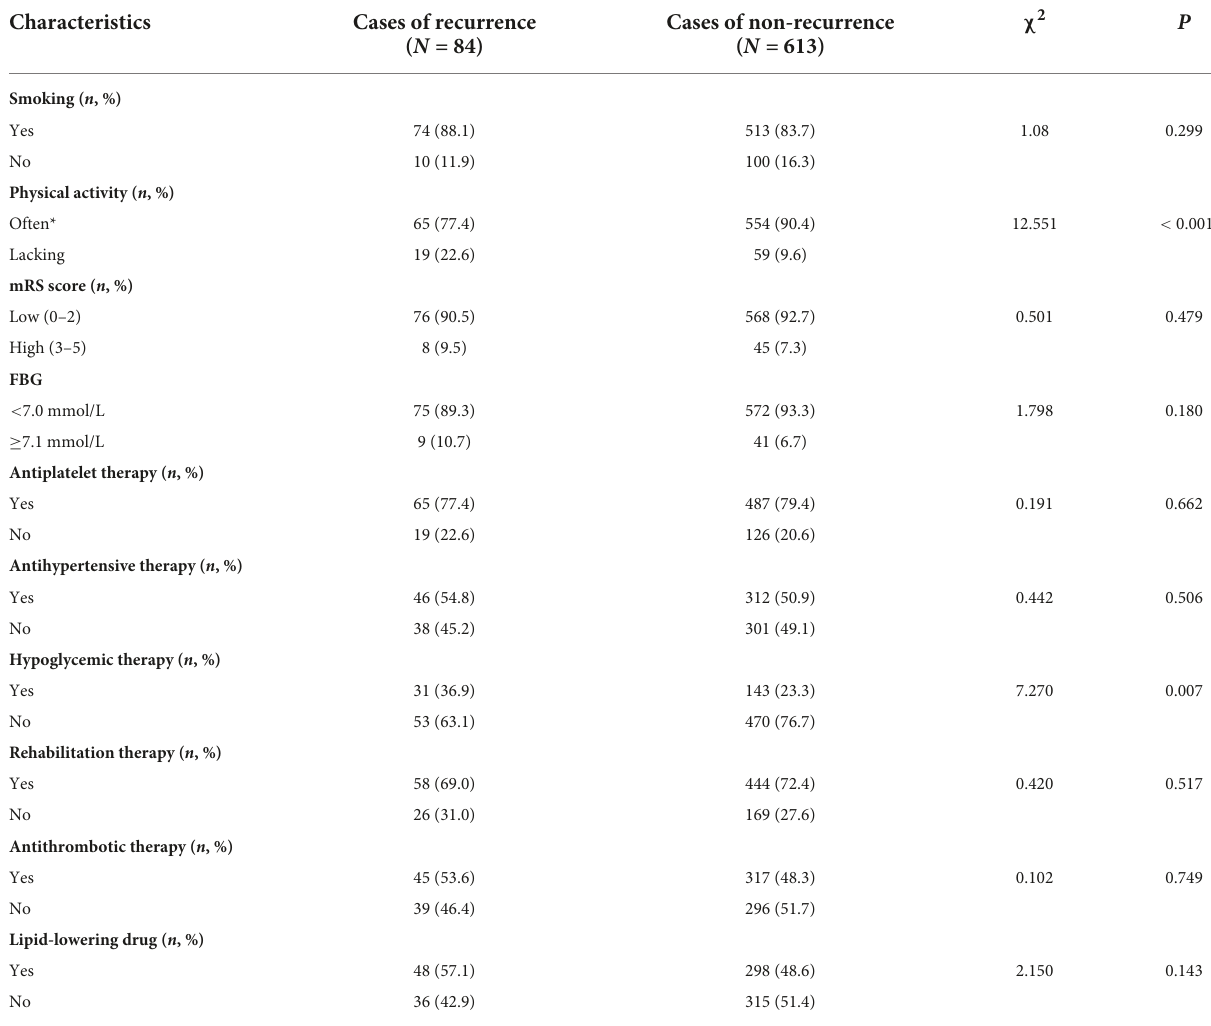
TABLE 2 Parameters during